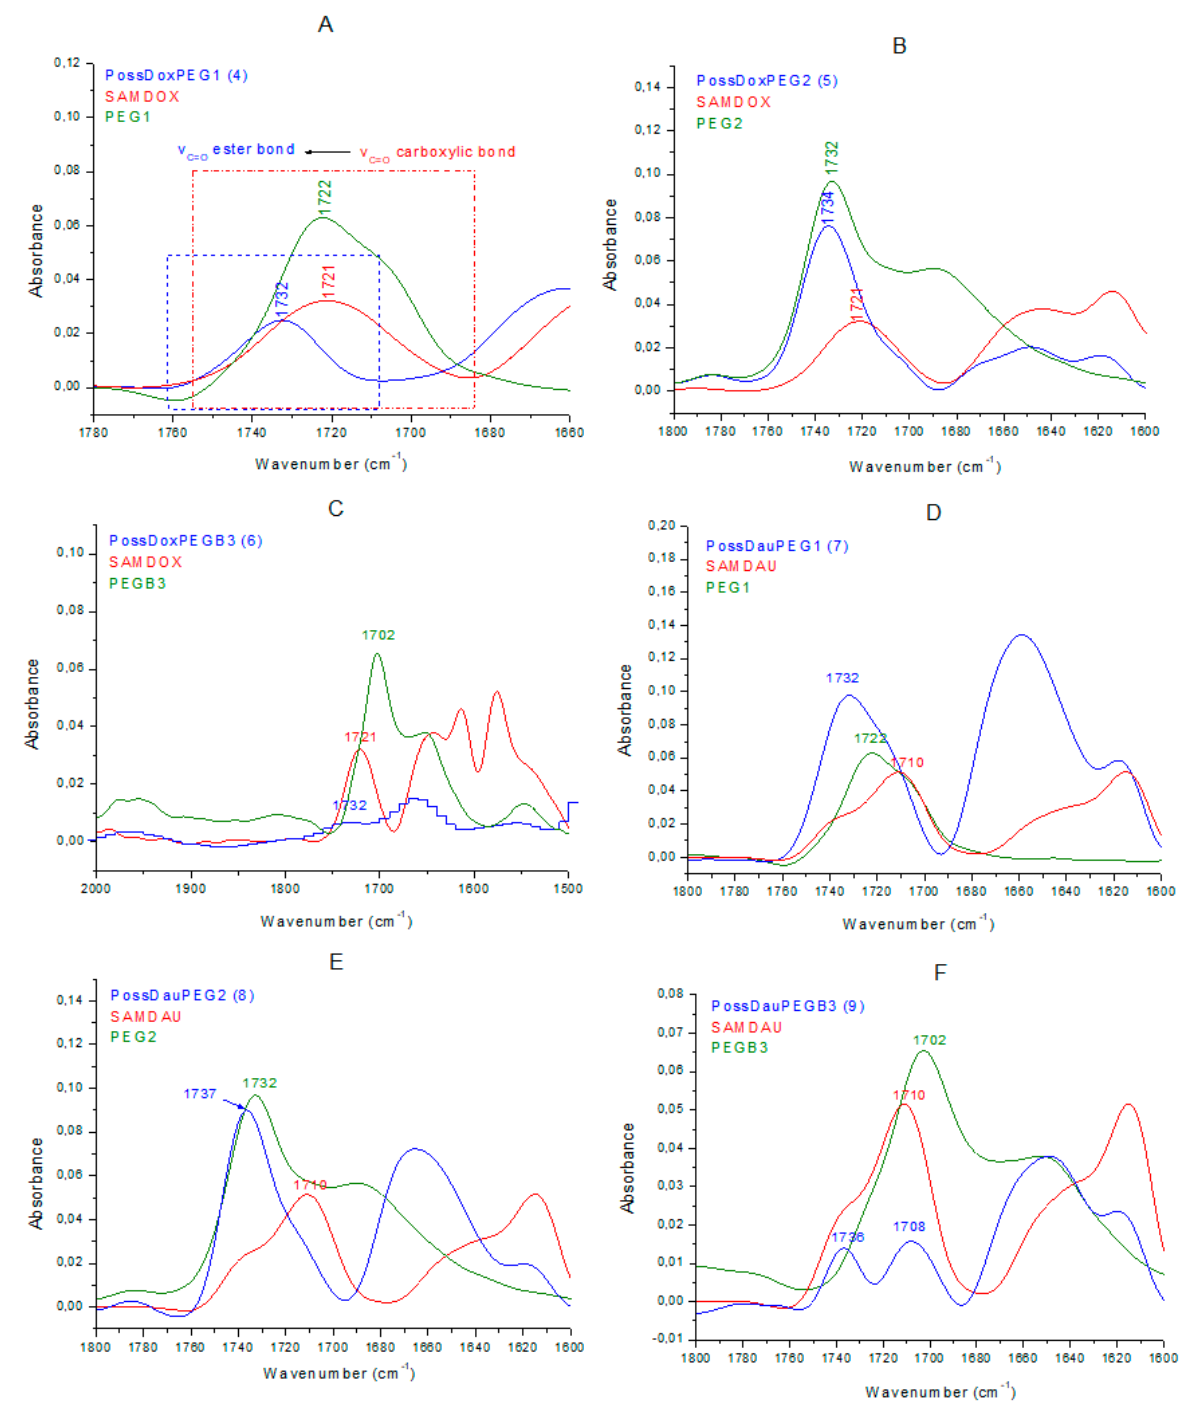
Figure 10. FTIR spectra of conjugates 4 – 9 compared with the ones of anthracyclines and PEGs (vibration range— ν c=o, ester bond). ( A ) PossDoxPEG1 ( 4 ); ( B ) PossDoxPEG2 ( 5 ); ( C ) PossDoxPEGB3 ( 6 ); ( D ) PossDauPEG1 ( 7 ); ( E ) PossDauPEG2 ( 8 ); ( F ) PossDauPEGB3 ( 9 )